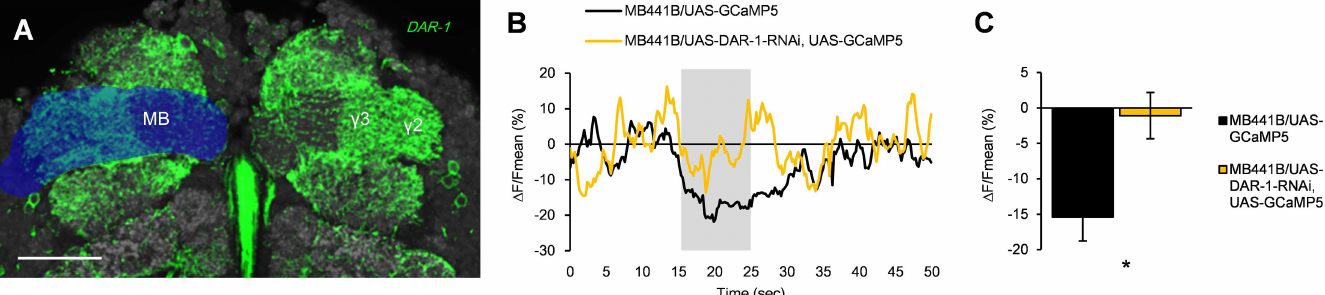
Fig 8. DAR-1 signaling is required for sugar-induced suppression of PAM- γ 3activity. (A) DAR-1-GAL4 expressionin PAM- γ 3. The MB γ lobe is labelledin blue. Scale bar, 20 μ m. (B) Averagedtime course of the baselineactivity of PAM- γ 3 with (yellow, n = 6 animals)or without (black, n = 5) DAR-1 knockdown. Gray bar: 500 mM sucrose application for 10 s. (C) Averagedcalcium responses of PAM- γ 3neurons. DAR-1 knockdown significantly attenuated sugar-induced suppression of PAM- γ 3 activity (Mann–Whitney test, n = 5–6). * p < 0.05.